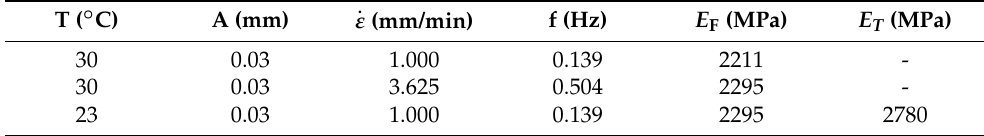
Table 2. Flexural and tensile moduli at 23 ◦ C for